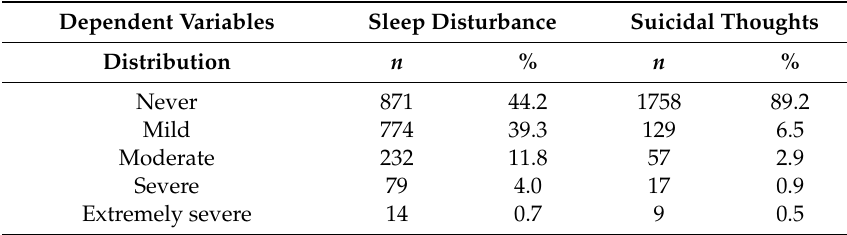
Table 3. Distribution of sleep disturbance and suicidal thoughts ( n = 1970).